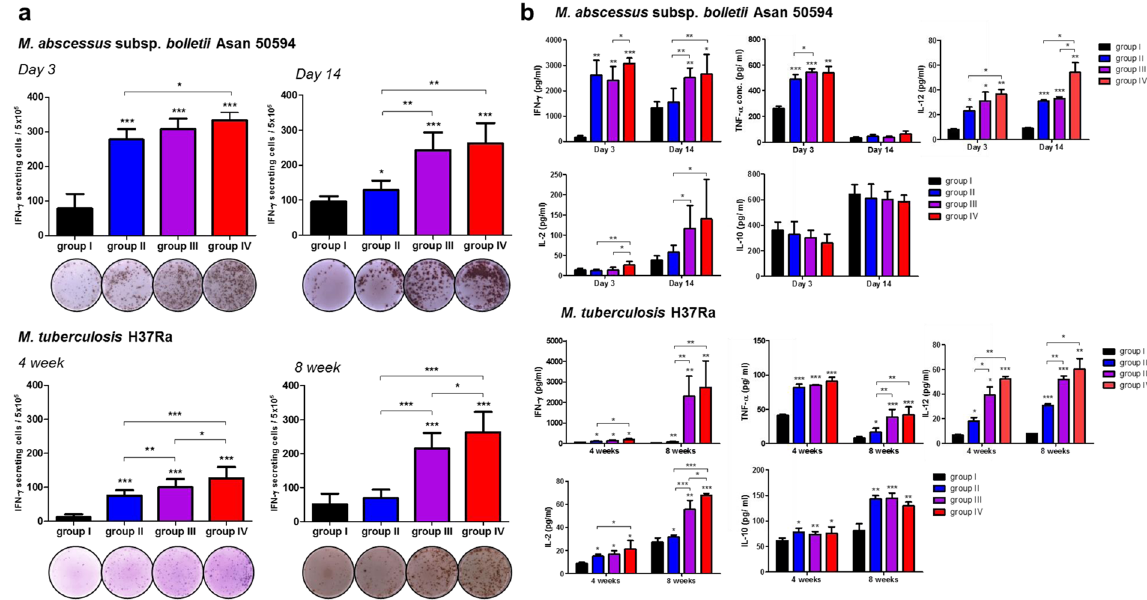
Figure 6. M . paragordonae (Mpg) elicits an enhanced cell mediated immune response against M. abscessus or tuberculosis infections in vaccinated mice. ( a ) Splenocytes from vaccinated (with BCG or Mpg) and challenged (with Mab or Mtb) mice (n = 3–5 per group) were stimulated with whole cell lysates of Mab and Mtb. The IFN- γ secretion levels were detected by ELISPOT analysis ( * P < 0.05, ** P < 0.01, *** P < 0.001; Student’s t -test). ( b ) IFN- γ , TNF- α , IL-2, IL-10 and IL-12 cytokine levels were detected from the culture supernatants of the in vitro stimulated splenocytes with whole cell lysates of Mab and Mtb by ELISA ( * P < 0.05, ** P < 0.01, *** P < 0.001; Student’s t -test). Each vaccinated group is annotated as follows: group I [PBS + PBS], group II [BCG + BCG], group III [BCG + Mpg], and group IV [Mpg +